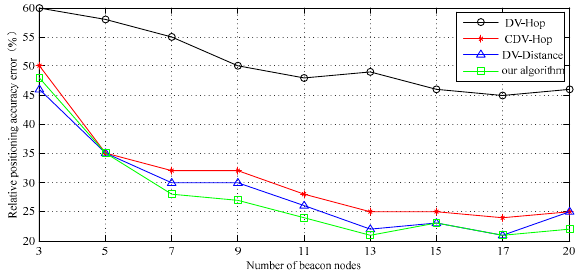
Figure 7. Localization error vs. Number of anchors.